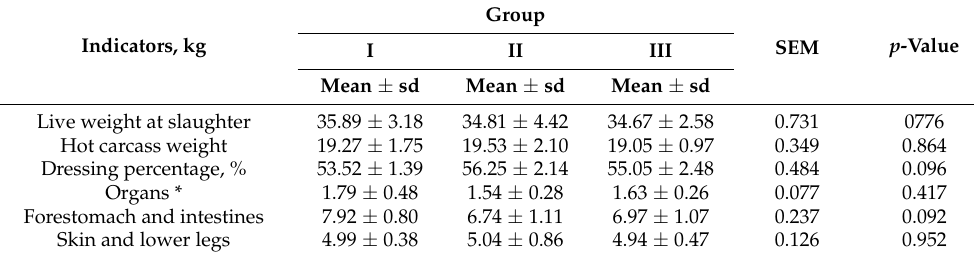
Table 3. Slaughter indicators of